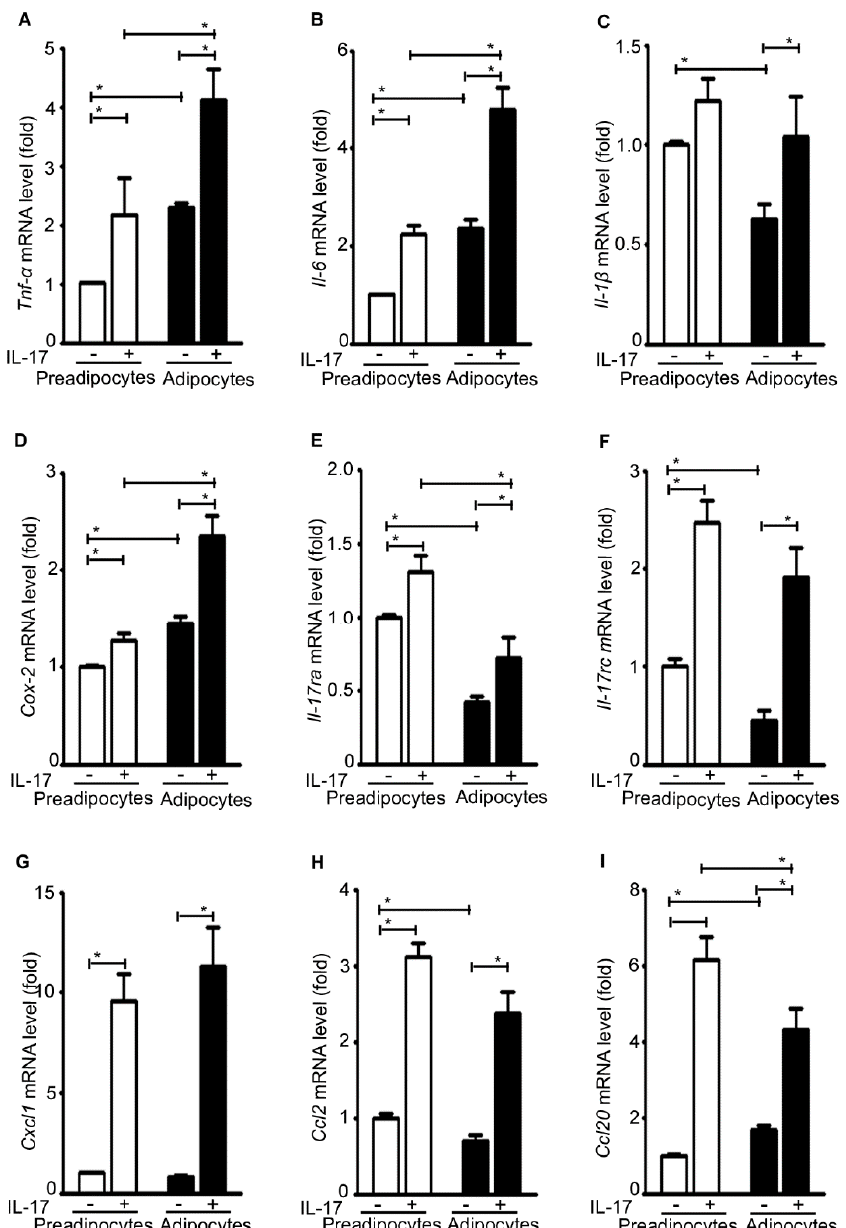
Figure 6. IL-17A differentially induces inflammatory gene expression in pre-adipocytes and ( A – I ) The pre-adipocytes and adipocytes were treated without ( ´ ) or with (+) 20 ng/mL IL-17A for 2 adipocytes. ( A – I ) The pre-adipocytes and adipocytes were treated without ( − ) or with (+) 20 ng/mL h; mRNA expression of each gene was analyzed with qRT-PCR; the pre-adipocytes without IL-17A IL-17A for 2 h; mRNA expression of each gene was analyzed with qRT-PCR; the pre-adipocytes treatment served as the basal level for comparison; data represent mean ˘ SEM (error bars) of six without IL-17A treatment served as the basal level for comparison; data represent mean ± SEM independent experiments ( n = 6 per group), * p < 0.05 between the indicated (error bars) of six independent experiments ( n = 6 per group), * p < 0.05 between the indicated groups.